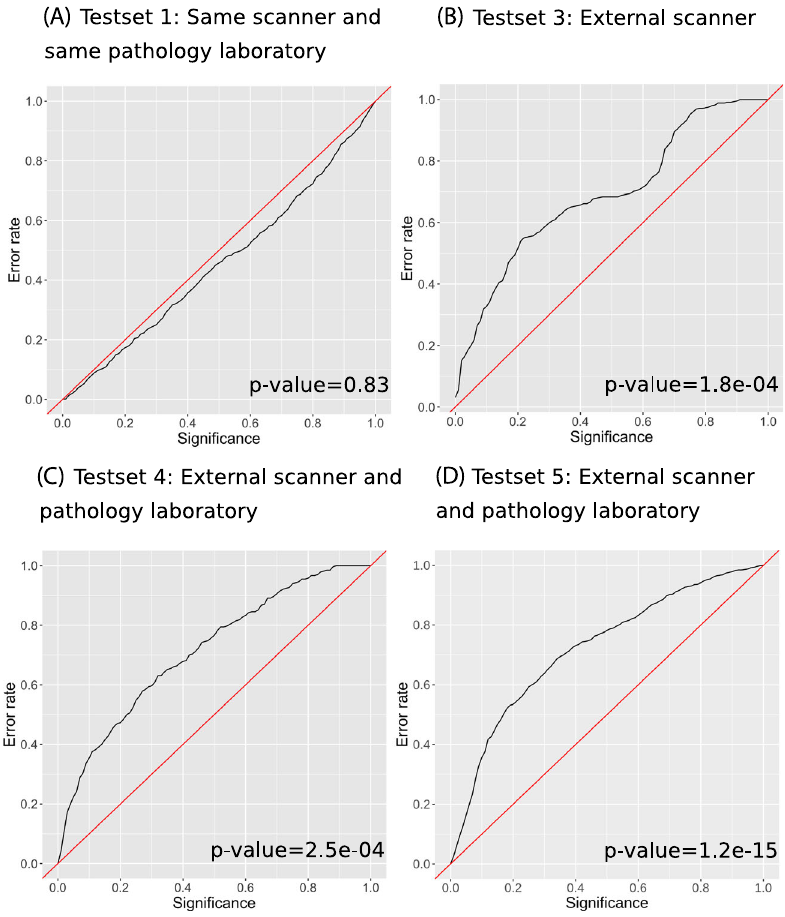
Fig. 2 | Calibration plot of the observed prediction error (i.e., the fraction of true labels not included in the prediction region) on the y -axis and the pre- speci fi ed signi fi cance level ε i.e., the tolerated error rate. The conformal pre- dictor is valid if the observed error rate does not exceed ε i.e., the observed error rateshouldbeclosetothediagonalline,thetoleratederrorrateforallsigni fi cance levels. The main advantage of conformal predictors is that they provide valid predictions when new examplesare independent and identicallydistributed tothe training examples. The graphs show results for Test set 1, 3, and 4, respectively. Panel A shows prediction regions on Test set 1, an independent test set consisting of794biopsiesfrom123menfromtheSTHLM3study,allfromthesamelaboratory as well as scanned on the same scanners as the training data. Panel B shows pre- diction regions on Test set 3 (external scanner), a set of 449 slides, held out from training,thatwasscannedonadifferentscannerthanthetrainingdata.Toevaluate Test set 3 (external scanner), we excluded images scanned on Hamamatsu